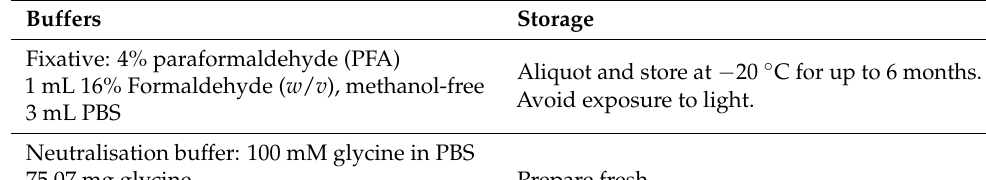
Table 2. Buffer preparation procedure. Buffers